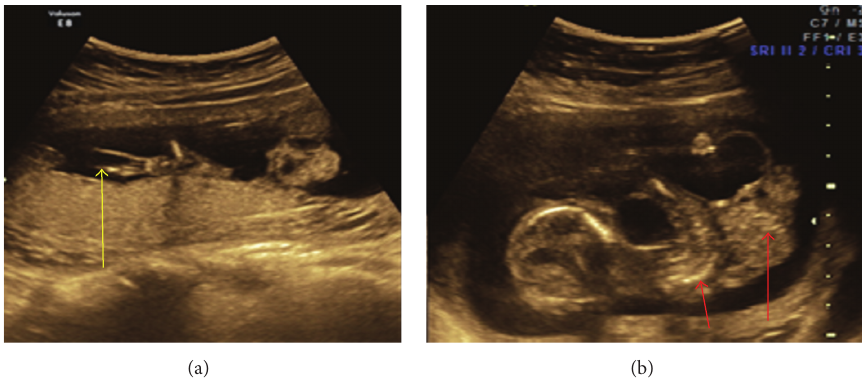
Figure 6: (a) Amniotic bands and (b) kyphoscoliotic deformity with herniation of abdominal content into the coelomic cavity.